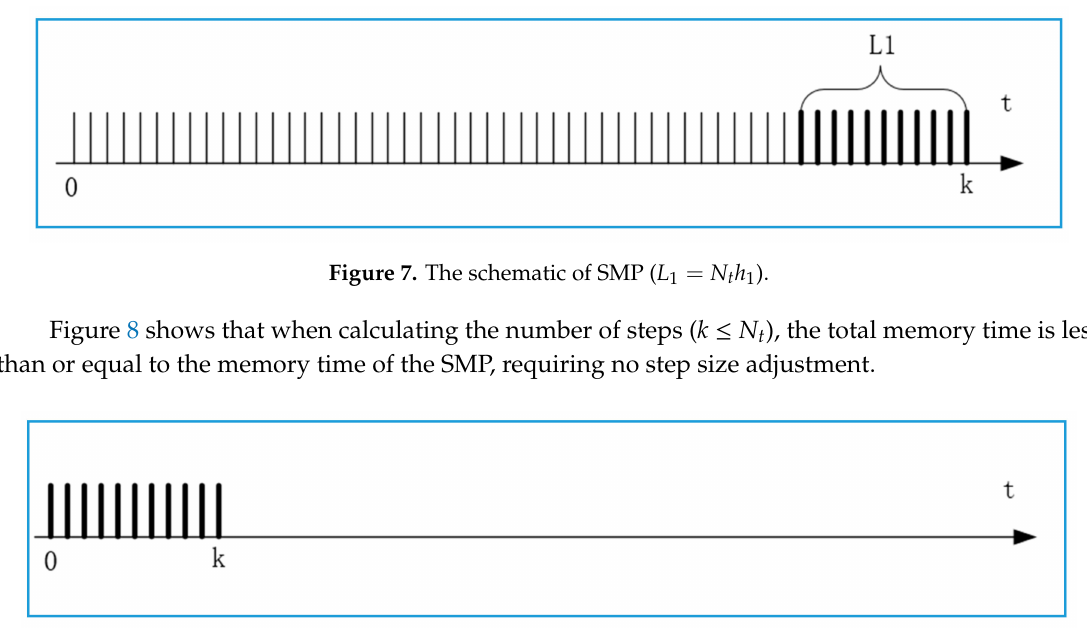
Figure 8. Schematic diagram of original definition method ( k ≤ N t ).